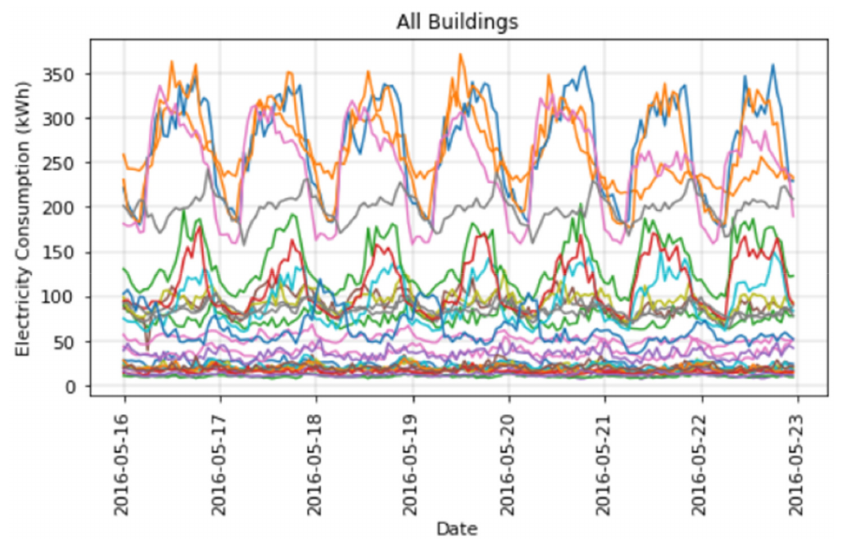
Figure 1. Hourly electricity consumption for the 28 considered buildings in a generic week of the measuring period.